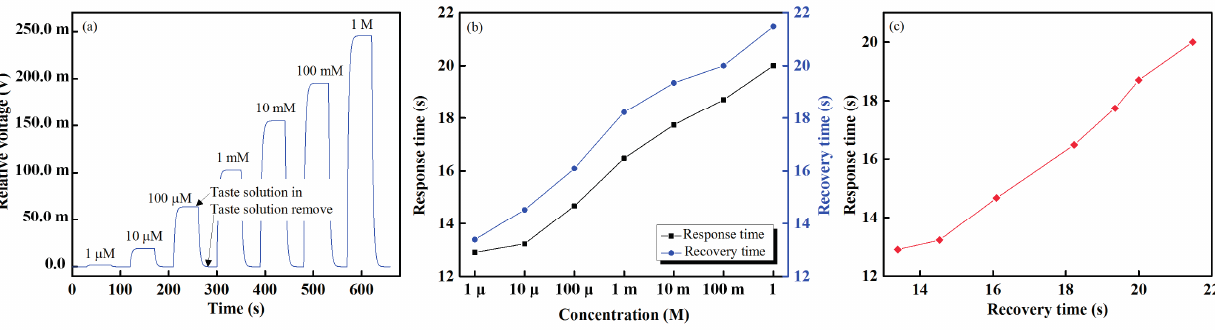
Figure 11. Sensing performance of the IDC taste sensing system: ( a ) real-time taste sensing responses of HCl; ( b ) response and recovery times; and ( c ) response versus recovery times at different concentrations of